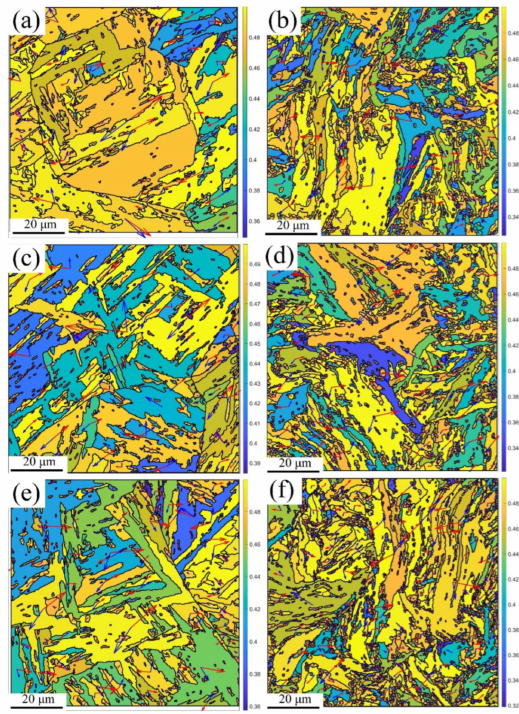
Figure 8. Schmid factor with slip plane (red arrows) and slip direction (blue arrows) maps for the medium ( a , c , e ) and maximum ( b , d , f ) degrees of deformation at RT ( a , b ); 430 ◦ C ( c , d ); and 630 ◦ C ( e , f